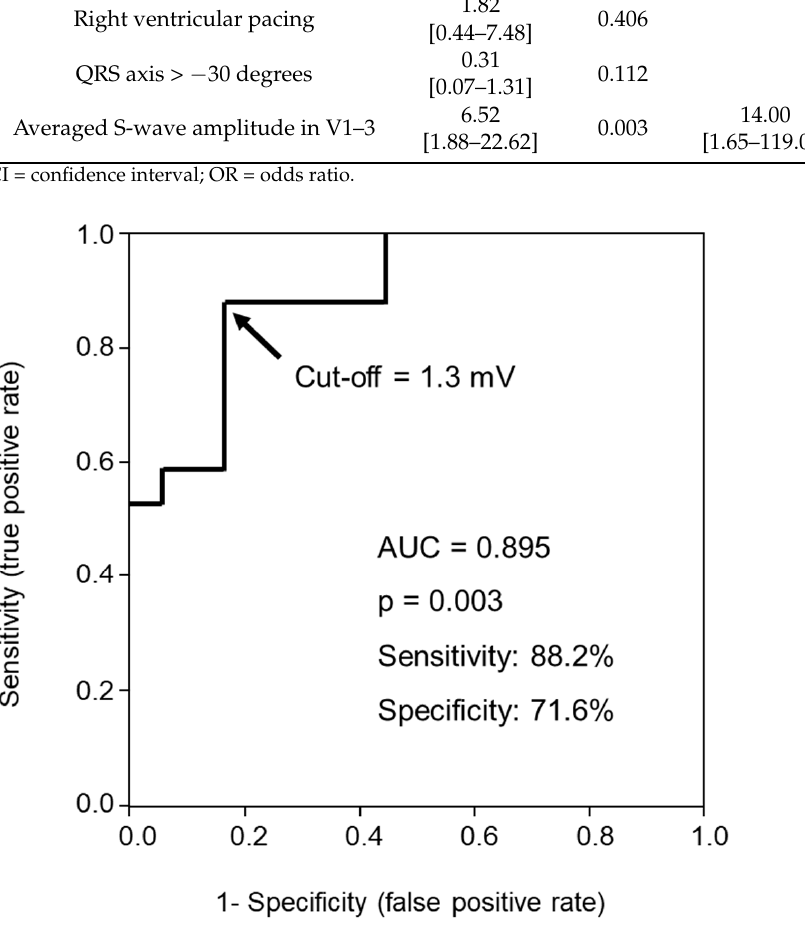
Figure 1. Receiver operating characteristic curve of averaged S-wave amplitude in right precordial leads for predicting mitral regurgitation reduction following cardiac resynchronization therapy. Representative ECGs and echocardiograms are displayed in Figure 2. Figure 2A,B present complete LBBBs. The averaged S-wave amplitude in right precordial leads is higher in Figure 2A (2.8 mV), with a considerable improvement in MR, whereas Figure 2B displays a low S-wave amplitude (1.2 mV), with MR remaining the same. Figure 2C,D present right ventricular apical pacing. The averaged S-wave amplitude in right precordial leads is higher (1.5 mV) in Figure 2C, with a considerable reduction in MR, whereas MR persists in Figure 2D with low S-wave amplitude (0.8